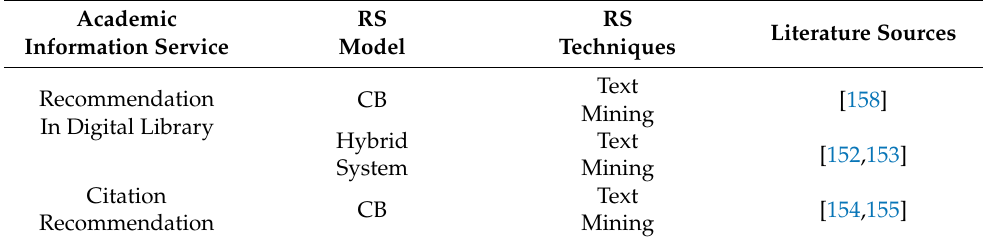
Figure 22. Citation list recommendation system. Table 11. Recommendation system study of academic information service field.